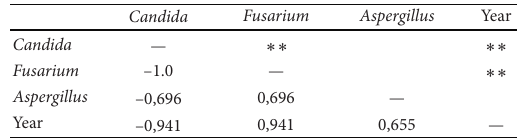
Figure 7: Statistical dependence between fungi and